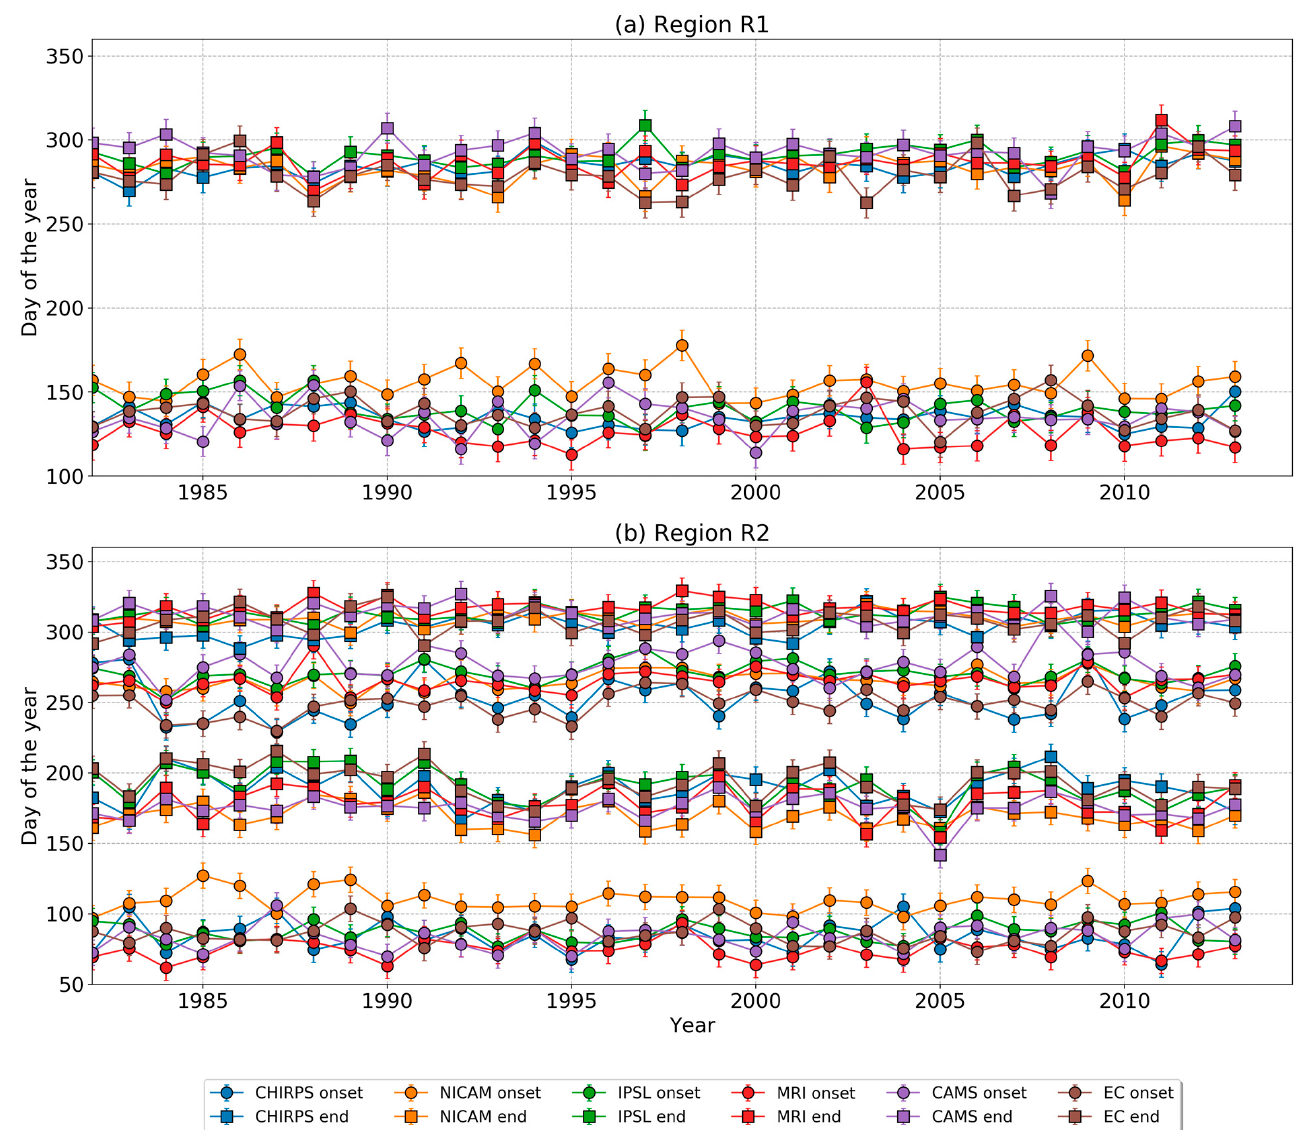
Figure 10. Time series of mean onset and cessation over regions ( a ) R1 and ( b ) R2. Different coloured lines indicate different data sets. The error bars show the standard deviation in onset/cessation across the region at each time.